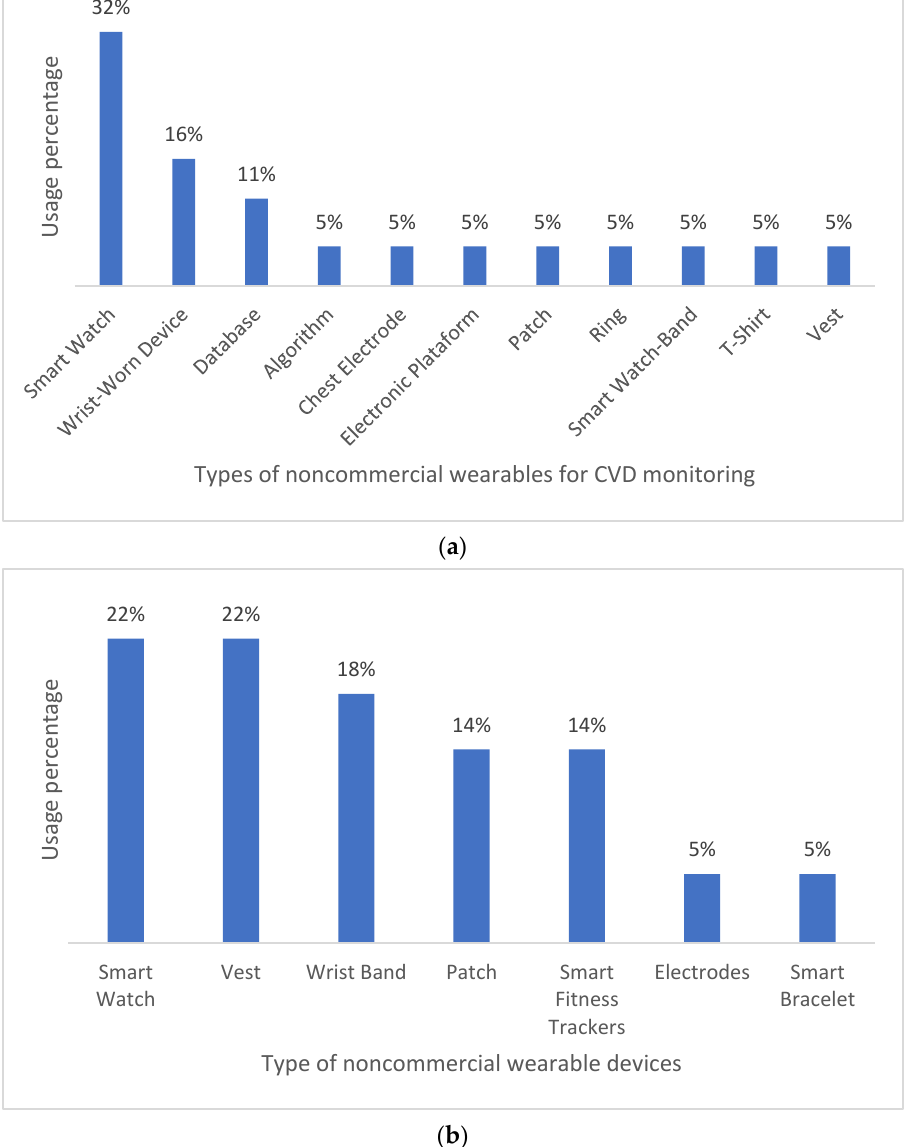
Figure 6. Types of noncommercial wearables for CVD monitoring — ( a ) atrial fibrillation and ( b ) heart failure.